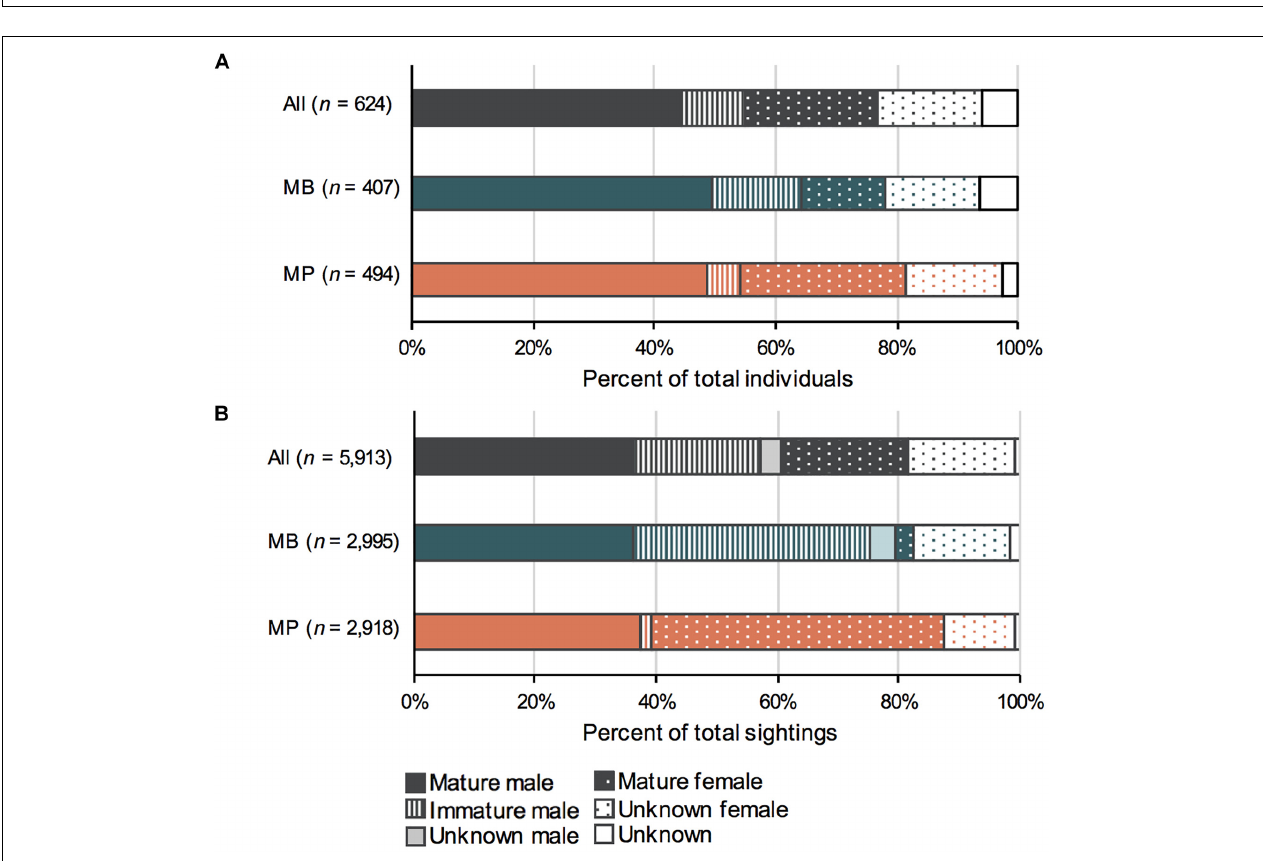
FIGURE 3 | Population structure of manta rays in the Nusa Penida MPA, with (A) the number of individuals and (B) the number of sightings for Nusa Penida (All) and the two sites Manta Bay (MB) and Manta Point (MP). Based on sightings from January 2012 to April 2018. Percentages were calculated from the total number of individuals (A) or sightings (B) for each site.